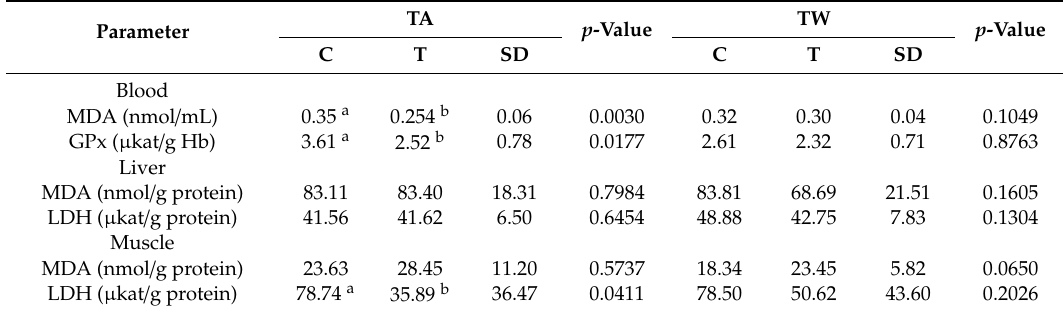
Table 4. E ff ects of thymol on the antioxidant parameters and activity of lactate dehydrogenase (LDH) in rabbit blood, liver and muscle.